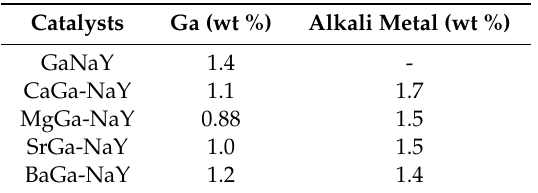
Table 1. ICP-OES metal ratios of the fresh NaY catalysts.